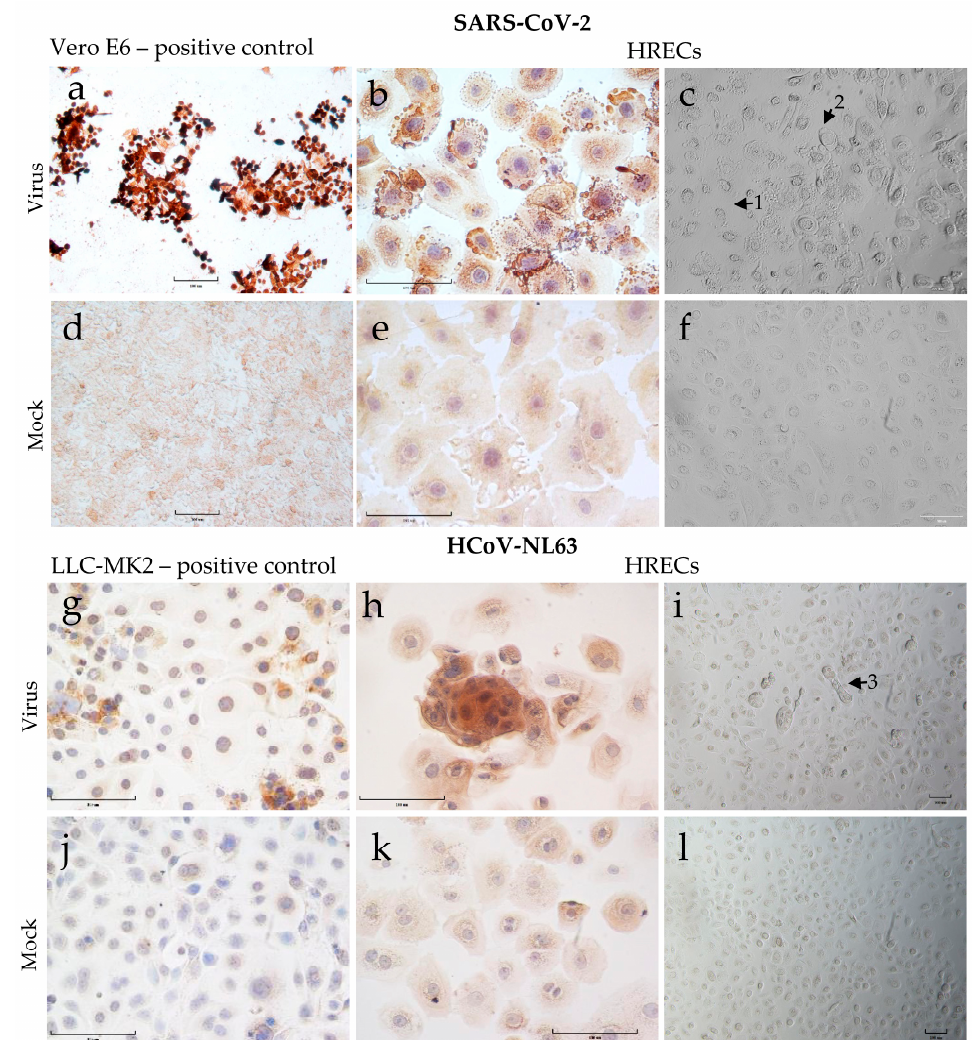
Figure 3. Cytopathic effect (CPE) and detection of viral nucleoprotein (SARS-CoV-2 or HCoV-NL63) in human respiratory epithelial cells (HRECs) and the Vero E6 and LLC-MK2 cell lines used to propagate SARS-CoV-2 and HCoV-NL63. Cells fixed in 4% paraformaldehyde were stained with ImmPRESS VR anti-mouse/rabbit IgG horseradish peroxidase (HRP) polymer detection kit. Anti-SARS Coronavirus/SARS-Related Coronavirus 2 nucleocapsid (N) protein (0.75 µg/mL), and anti-HCoV-NL63 nucleocapsid (N) protein monoclonal antibody (0.25 µg/mL) were used to detect corresponding viruses. Dark brown indicates the presence of a viral protein that interacts with a specific antibody, which is considered a positive expression; pale brown denoted background straining, and the nucleus was counterstained blue with hematoxylin. ( a ) Vero-E6 cells after 72 h post-inoculation (hpi) with SARS-CoV-2 as positive control; ( b ) HRECs after 72 hpi with SARS-CoV-2; ( c ) HRECs showing CPE after 120 hpi with SARS-CoV-2 (1—dying cells, 2—rounding of cells); ( g ) LLC-MK2 cells after 120 hpi with HCoV-NL63; ( h ) HRECs after 120 hpi with HCoV-NL63. ( i ) HRECs showing CPE after 120 hpi with HCoV-NL63 (3—cells mostly healthy looking but with syncytia formation); ( d – f , j – l ) Respective mock inoculations with culture medium. Scale bar—100 µm.